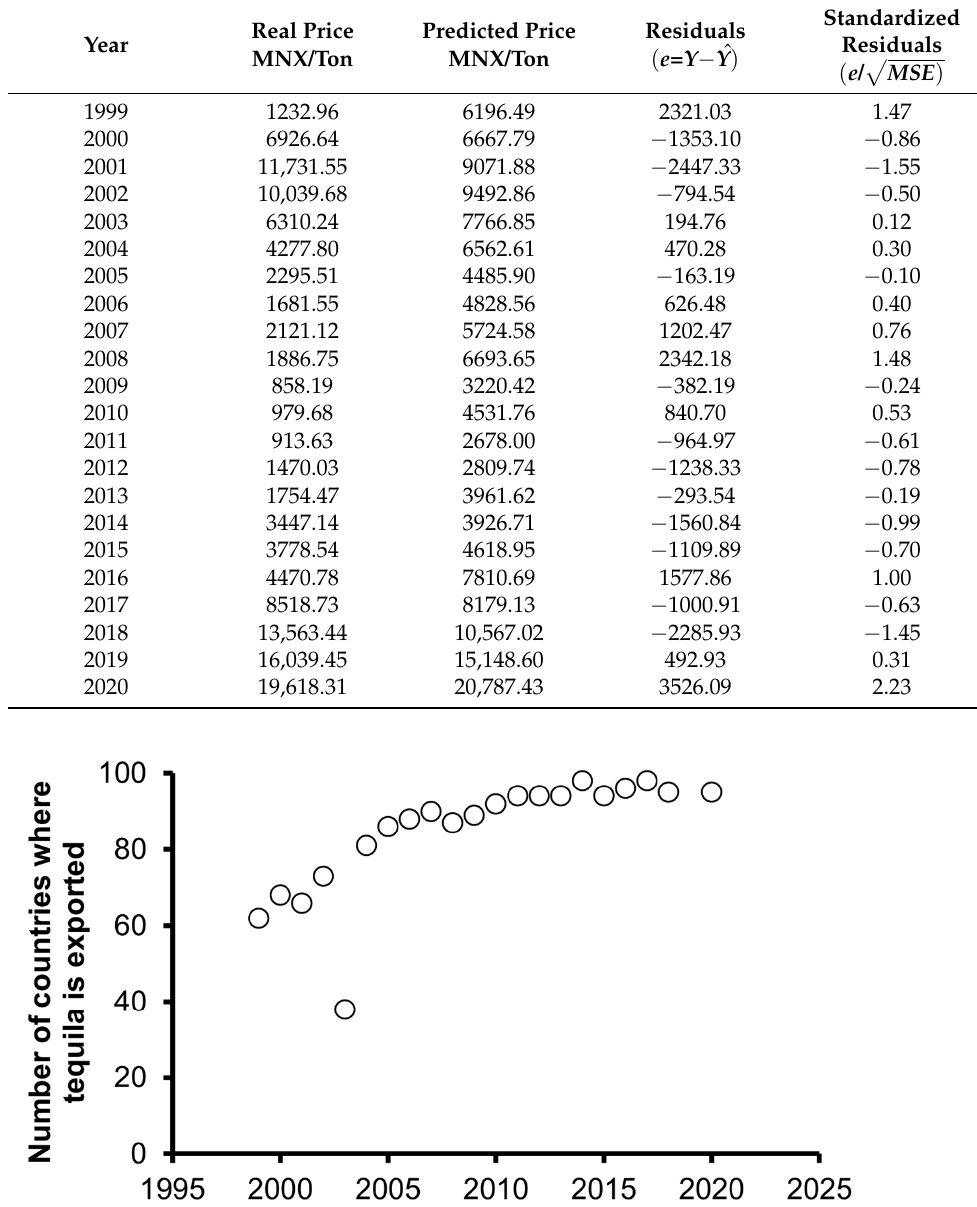
Table 3. Agave price 1999–2020 history statistics and model fitting.